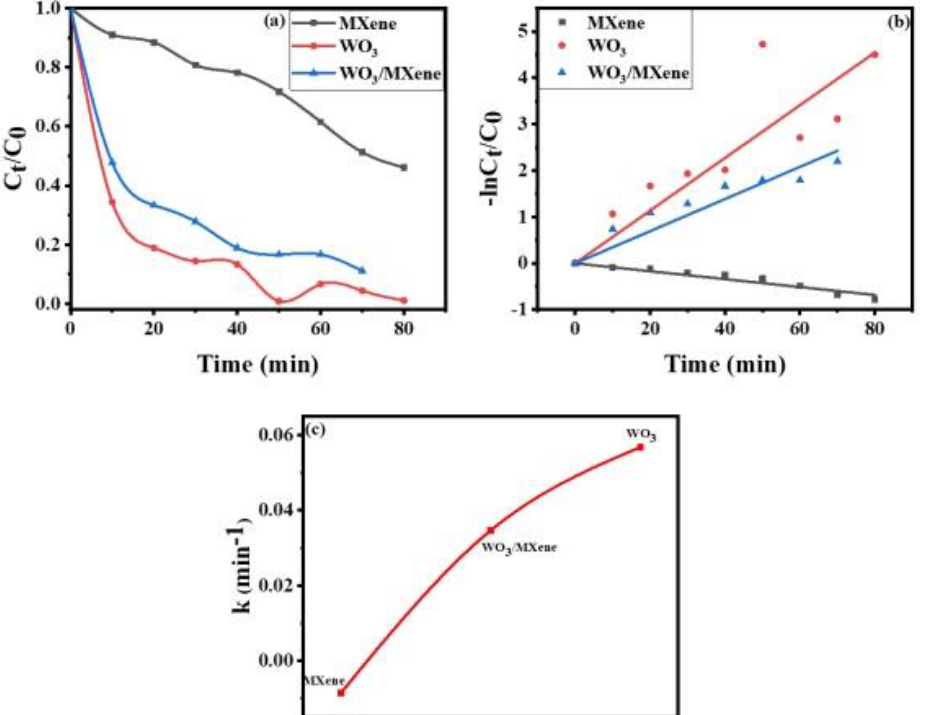
Figure 9. ( a – c ) Kinetic study for rate constant of MXene, WO 3 , and WO 3 /MXene nanocomposite.